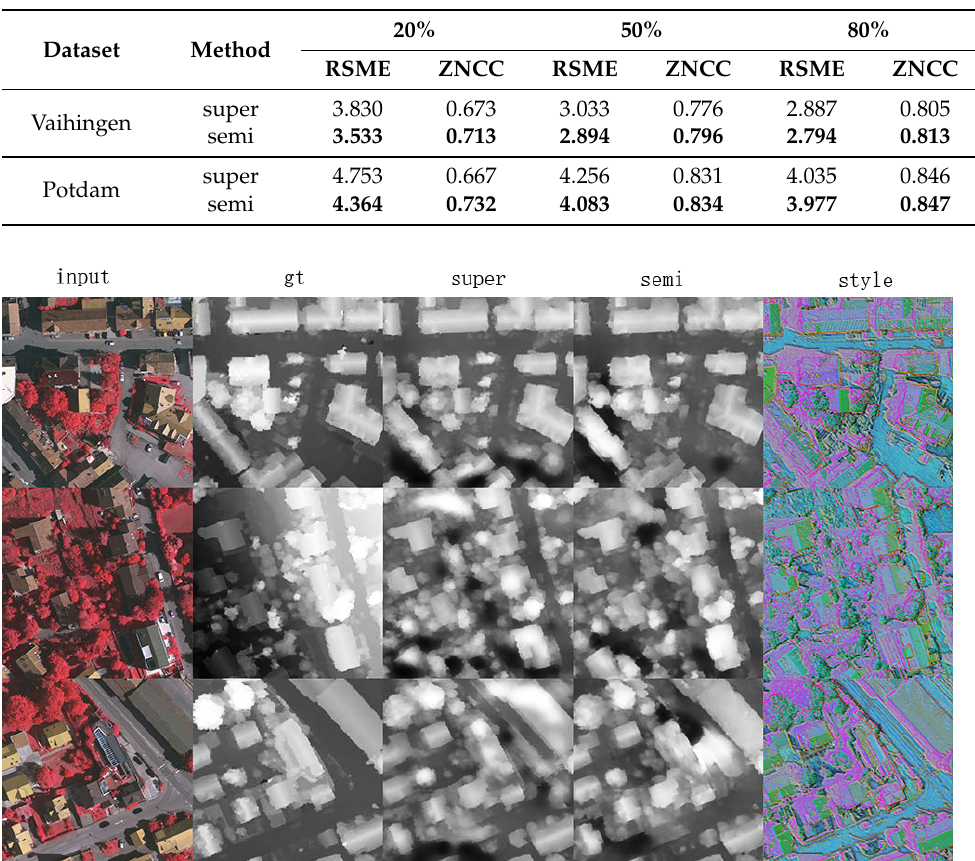
Figure 5. Three examples from the Vaihingen dataset in inner-domain semi-supervised learning mode. The columns from left to right correspond to the test images, ground truth, supervised learning results, semi-supervised learning results, and corresponding style distribution